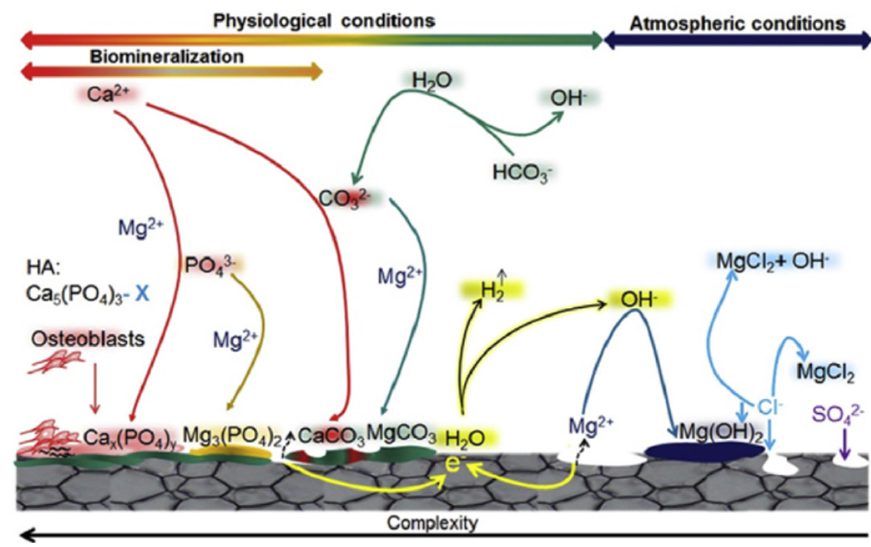
Figure 4. Production of numerous corrosion products in a physiological environment [8].